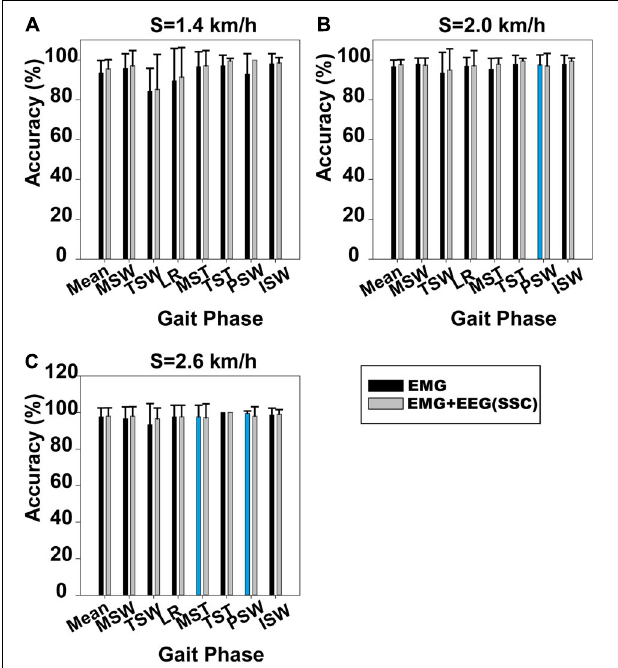
FIGURE 4 | Gait phase recognition based on case 2 and gait phase recognition based on case 3. (A) Walking speed 1.4 km/h, (B) walking speed 2.0 km/h, and (C) walking speed 2.6